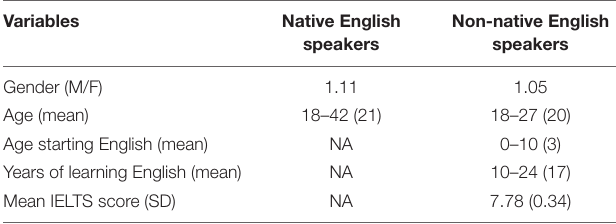
TABLE 1 | Demographics and language background of native and non-native speakers of English. Variables